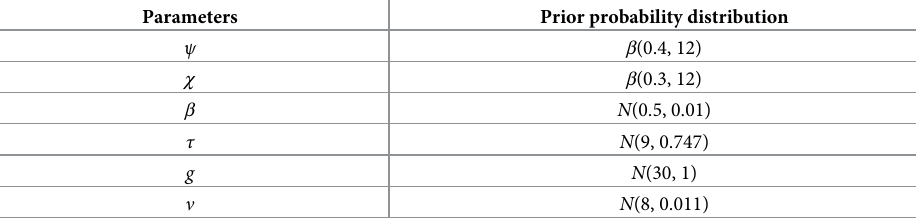
Table 3. List of parameters and their prior probability